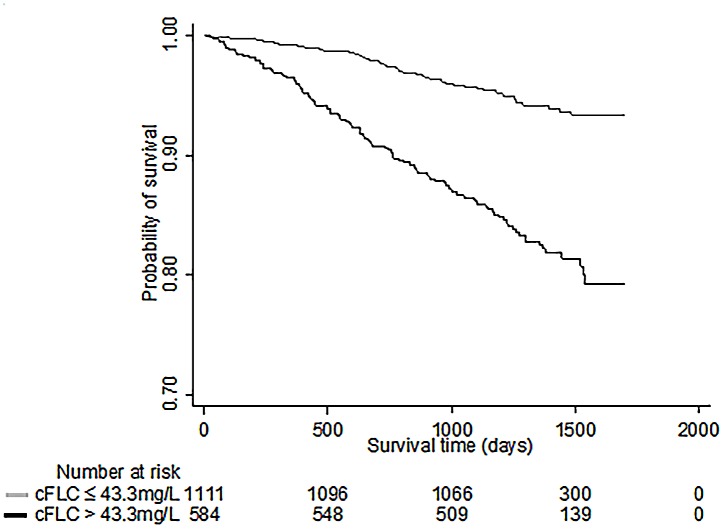
Kaplan-Meier plot of survival in people with elevated (>43.3mg/L) versus normal combined serum cFLC concentration.Participants with combined free light chains (cFLC) ≤43.3 mg/L had significantly longer overall survival compared to participants with cFLC >43.3 mg/L. Log rank analysis: P <0.001. Note that the x axis does not intersect the y axis at zero.